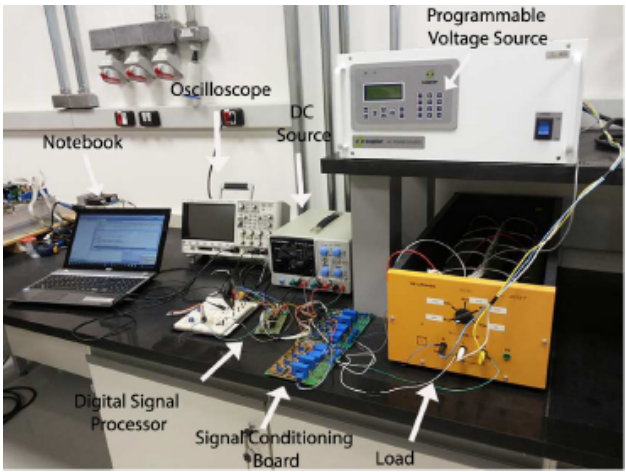
Figure 4. Experimental